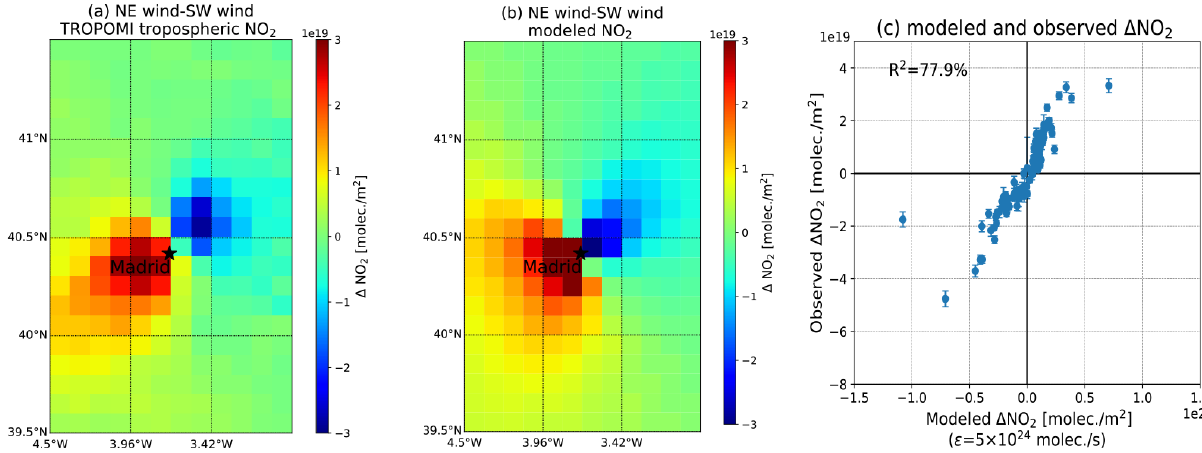
Figure 6. Wind-assigned anomalies derived from (a) TROPOMI tropospheric NO 2 column, (b) our simple plume model ( ε = 5 × 10 24 molec.s − 1 ) over Madrid in the NE–SW direction on a 0.1 ◦ × 0.135 ◦ latitude–longitude grid during 2018–2020, and (c) the corre- lation plot between observed (cid:49) NO 2 and modeled (cid:49) NO 2 ( ε = 5 × 10 24 molec.s − 1 ) during